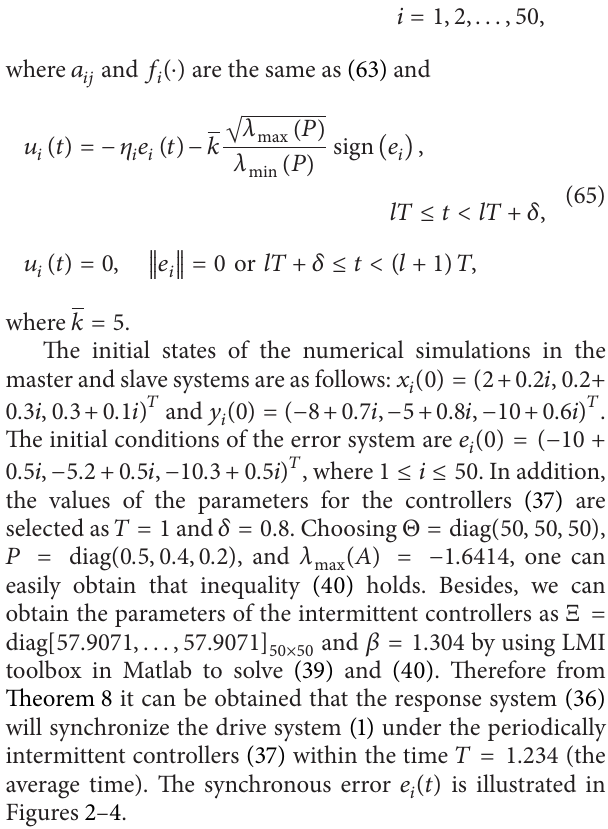
Figure 1: The chaotic trajectories of the Lorenz system.